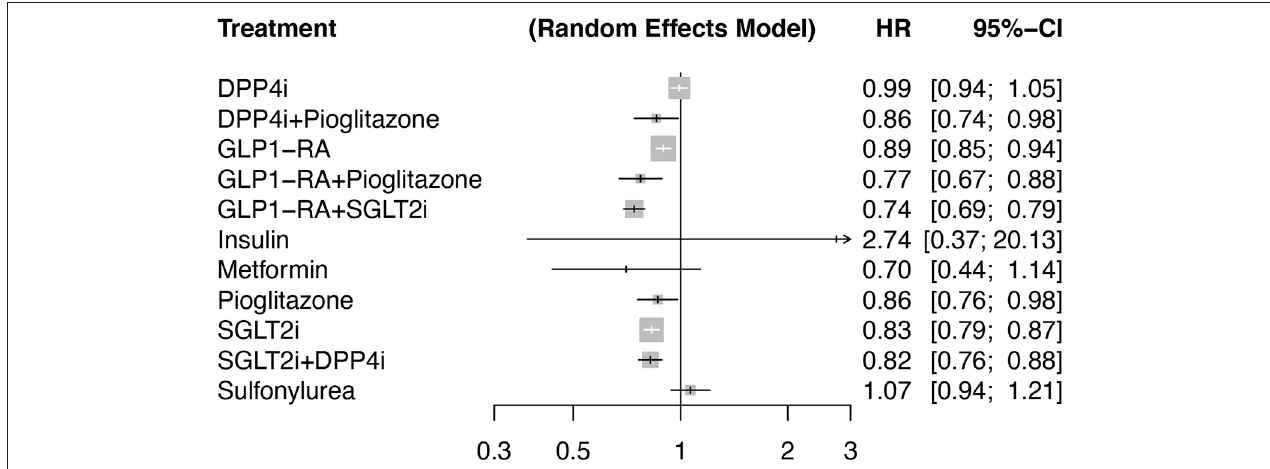
FIGURE 3 | Forest plot comparing antidiabetic therapies for the occurrence of major cardiovascular adverse events (MACE) in an additive effects network meta-analysis with a random-effects model. The reference group was considered as placebo. Number of pairwise comparisons was 140 (140 studies with > 100 individuals per arm), number of treatments ( n = 12), number of designs ( n = 25) with 7 active components. Heterogeneity / inconsistency analysis showed tau2 = 0; tau = 0; I 2 = 0% [0.0; 6.5%]; Q = 111.72 ( p = 0.91). Among TZDs (thiazolidinediones) only pioglitazone was included.